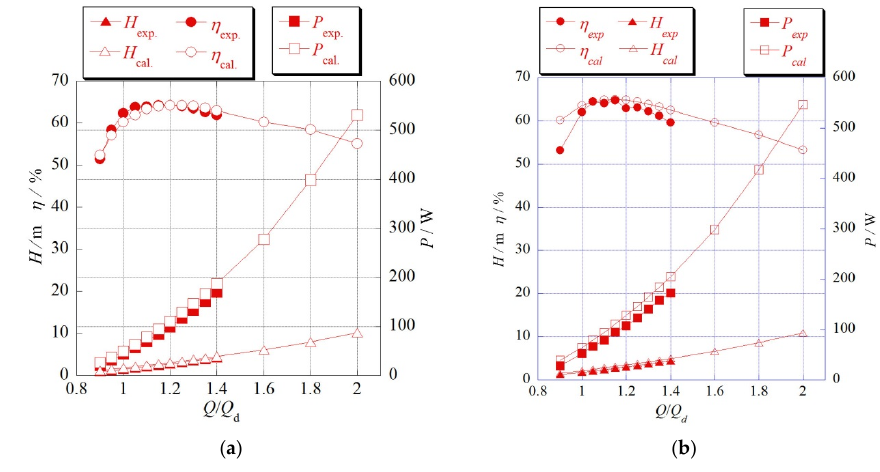
Figure 4. The picture of the experiment process, the flow direction is from left to right.